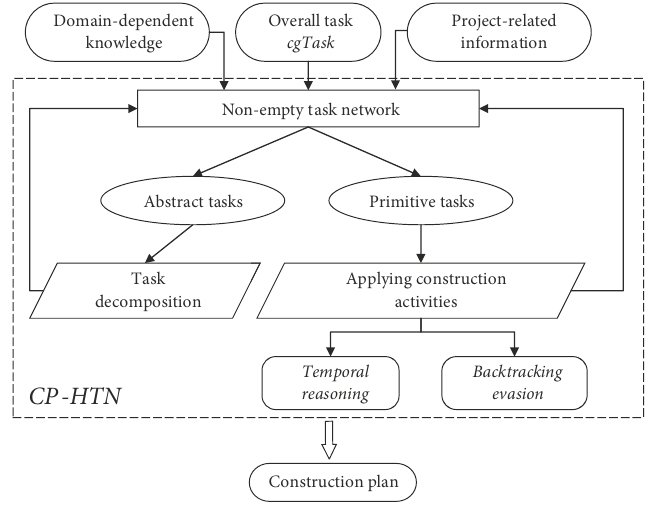
Figure 3. Overall framework of CP-HTN